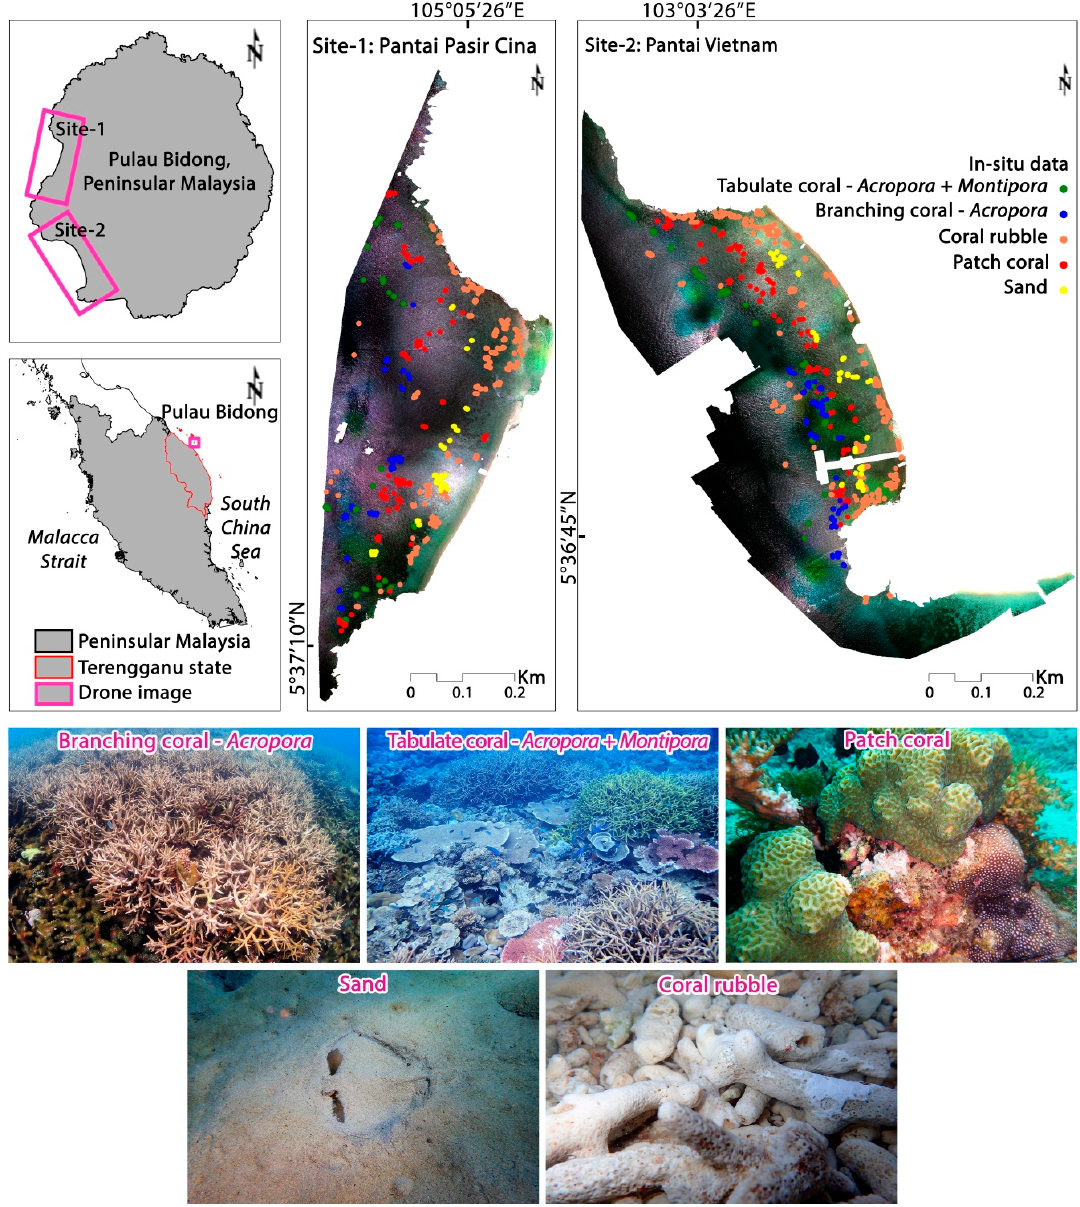
Figure 1. Study site map showing Pulau Bidong in Peninsular Malaysia and the locations of in situ data ( top ). Examples of digital photos of each coral habitat class, taken during field surveys, are given below.